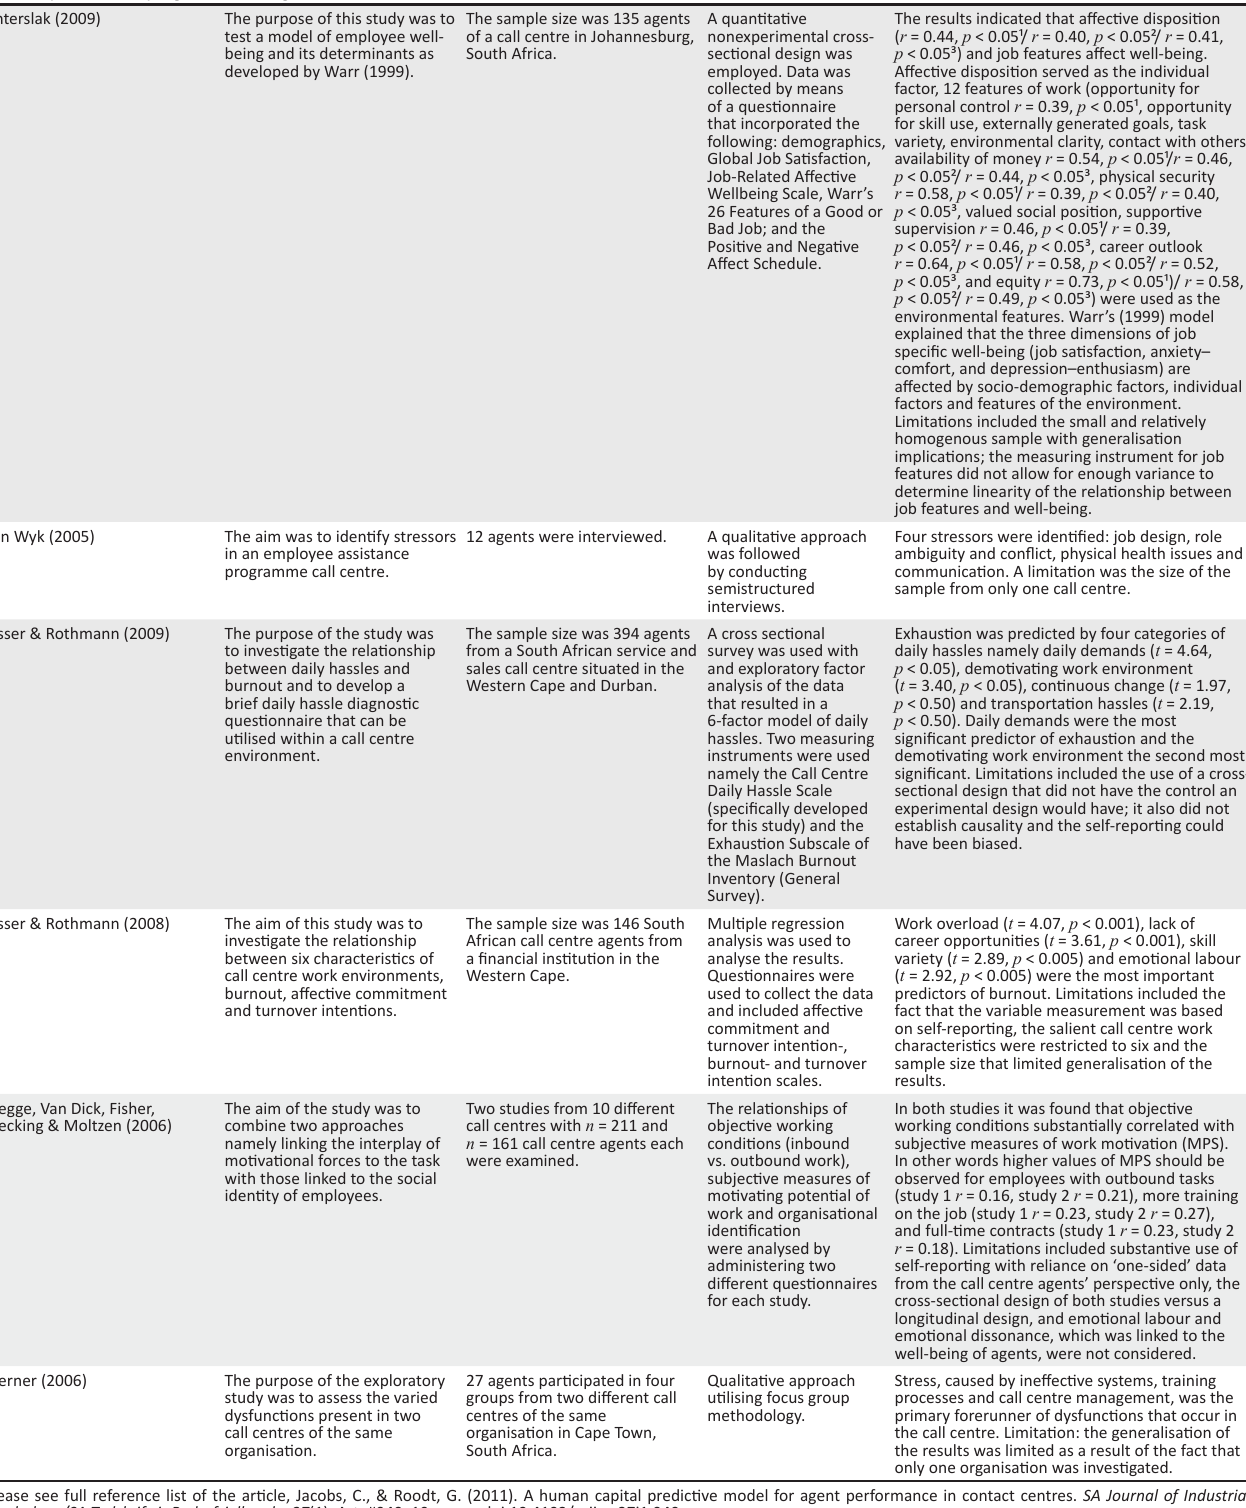
TABLE 6 (Continues...) : Agent